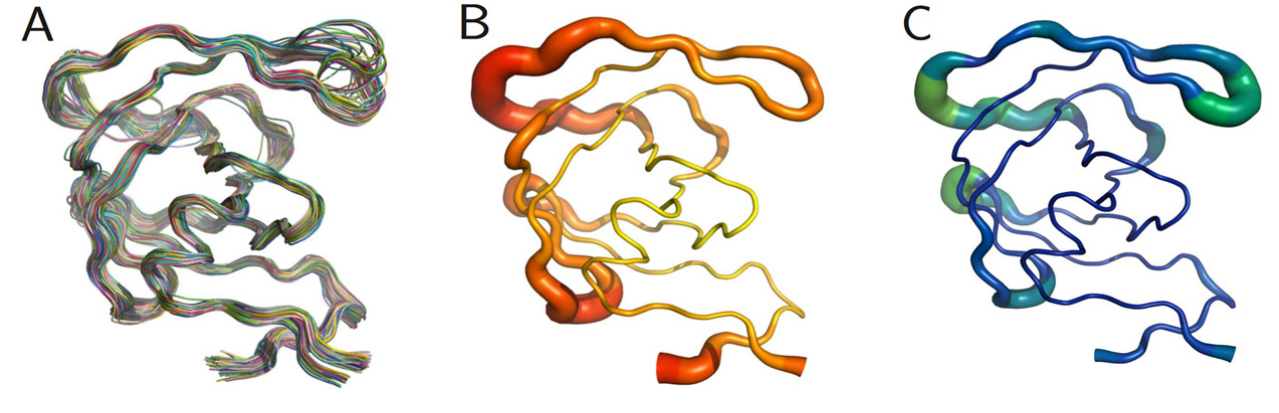
Figure 4. PR monomers. ( A ) Ribbon diagram of the final data set superposed by least squares. ( B ) Putty cartoon of B- factor variation on the mean structure, colored from low to high (yellow to red). ( C ) putty cartoon of spatial variation on the mean structure, colored from low to high (blue to green). Refer to figure 1 for definitions of PR regions. Rendered using PyMOL (DeLano,